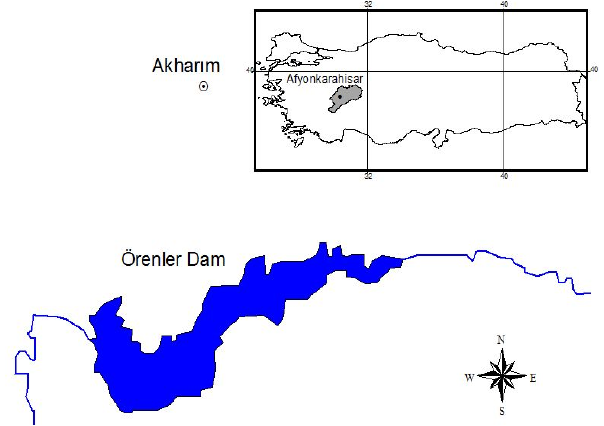
Fig. 1. Orenler dam lake, the studied site